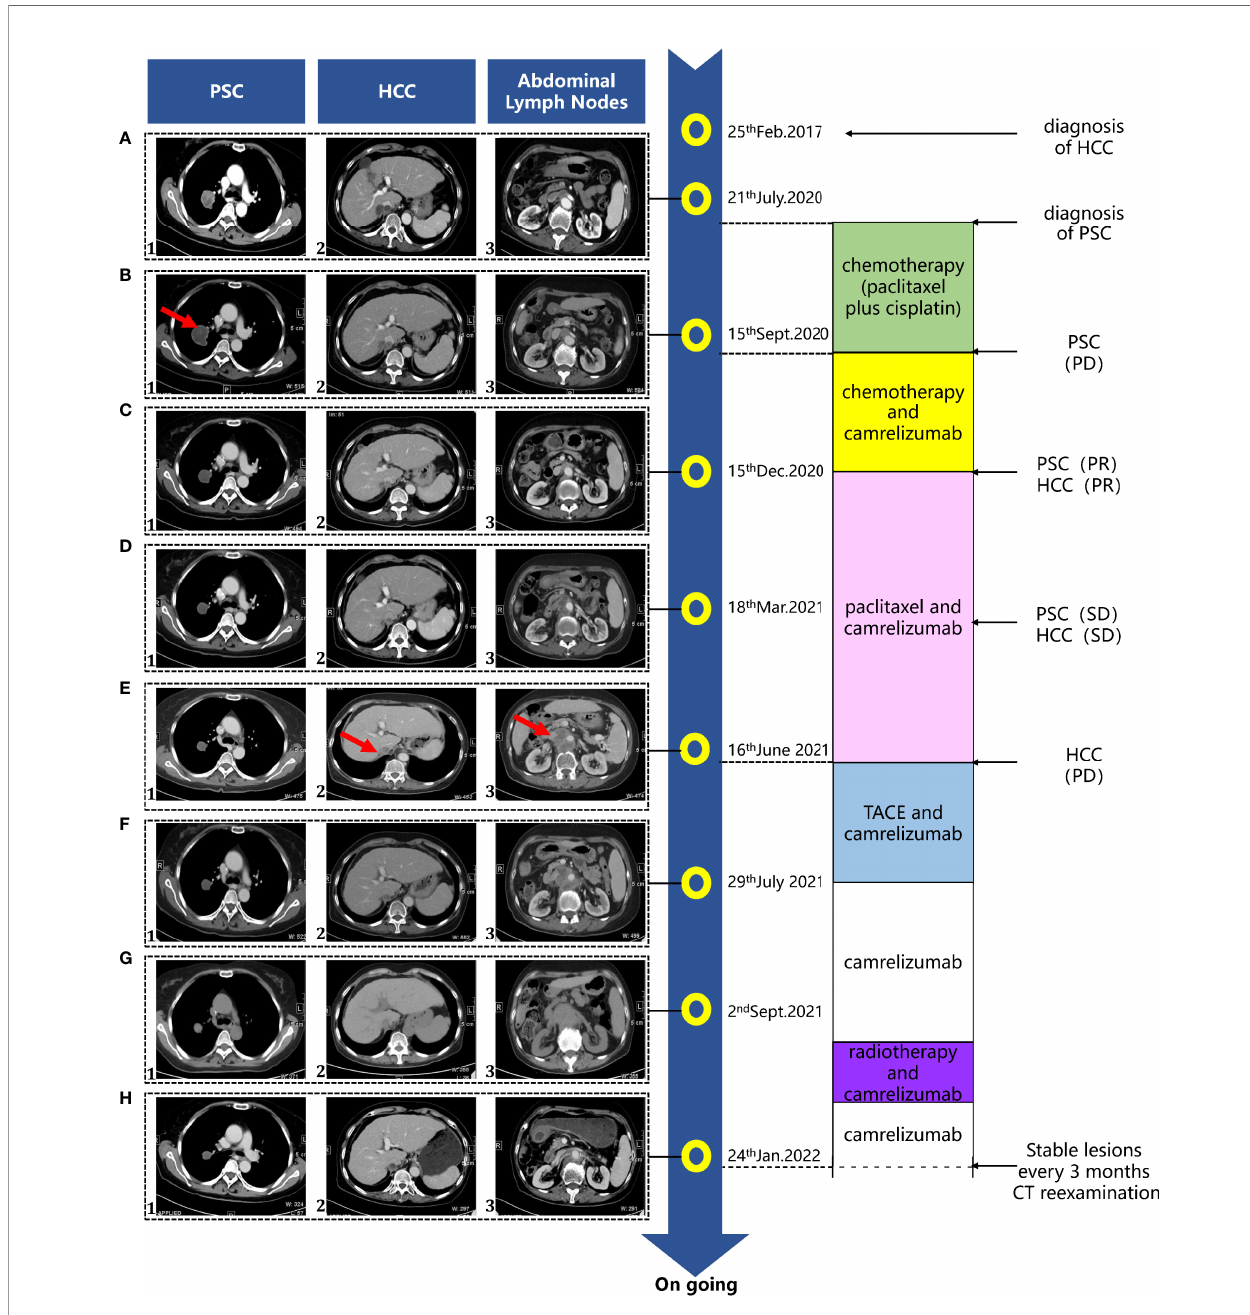
FIGURE 1 | Treatment timeline of the patient. Progressive lesions are indicated by red arrows. PD, progressive disease; PR, partial response; SD, stable